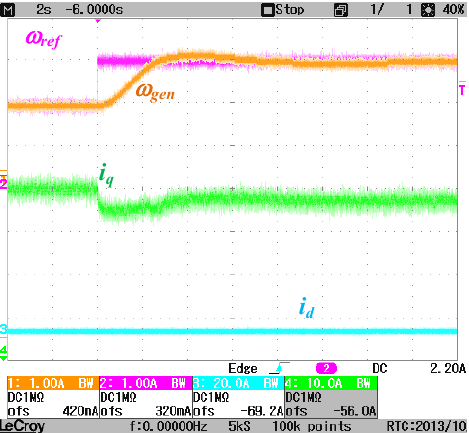
Fig. 18. Response for step change of speed without APFF. From top: dc-link voltage ( U dc ), grid voltage ( U grid ), grid current ( i grid ).